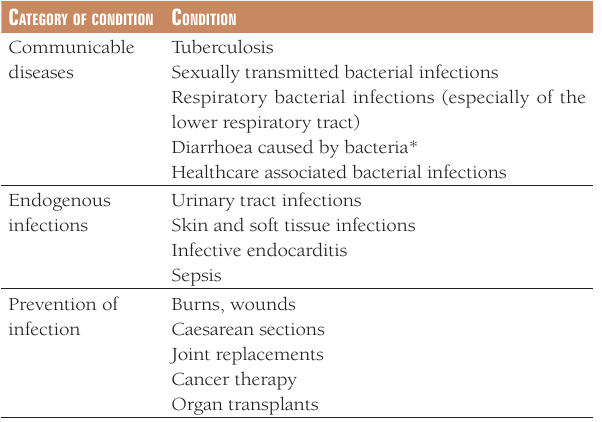
Table 1. Common clinical conditions for which antibiotic therapy reduces the risk of mortality C ategory of Condition C